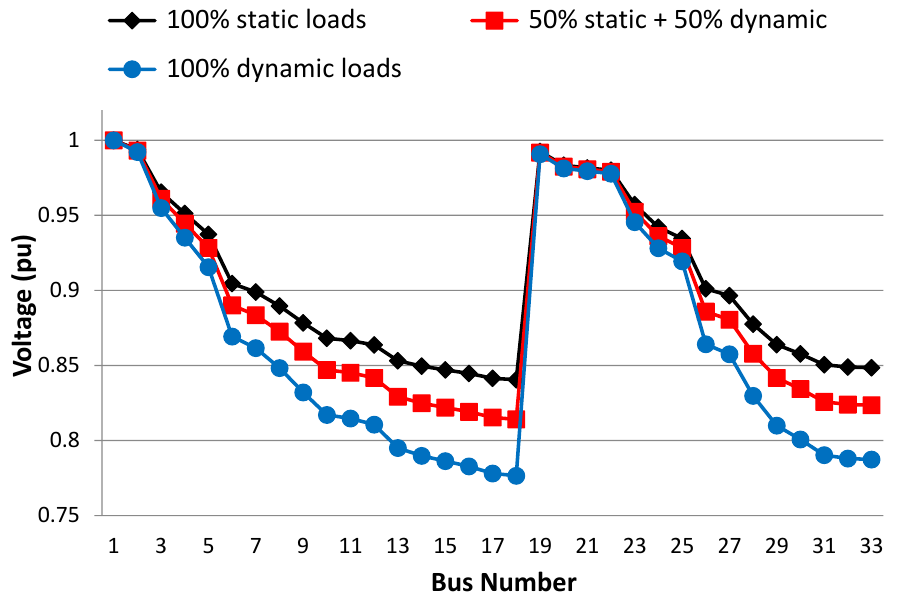
Figure 8. Effect of load type on voltage profile at 250% loading.